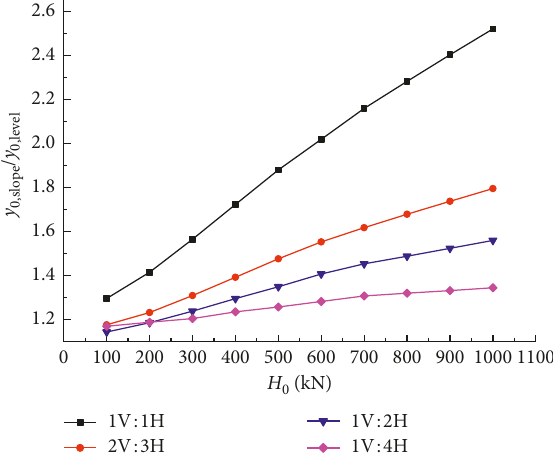
Figure 6: Curves of normalized displacement and lateral load for different slope